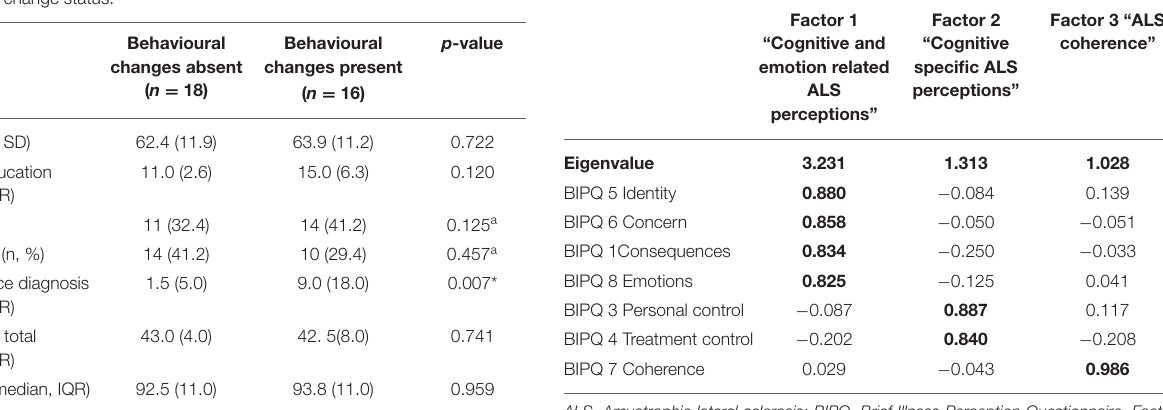
TABLE 3 | Rotated component matrix from principal component